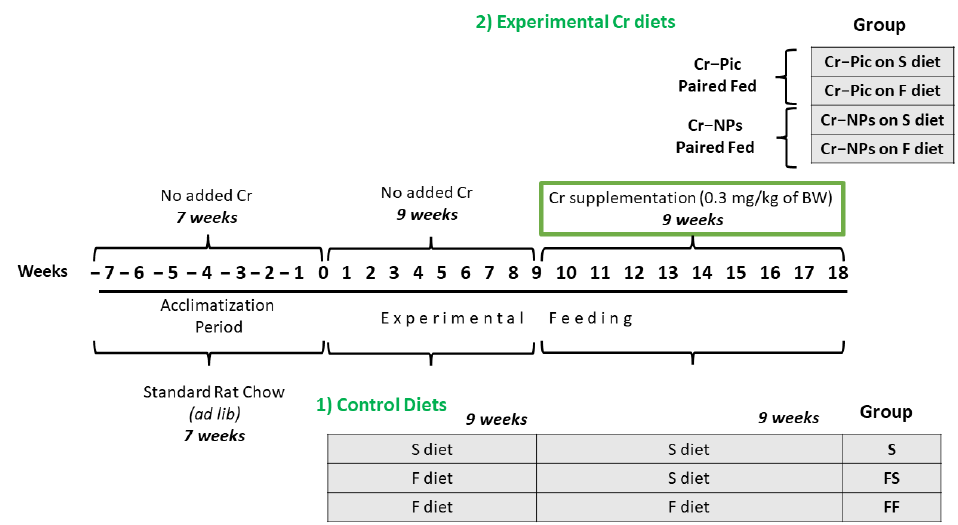
Figure 1. Animal feeding groups and experimental timeline. 0.3 mg Cr/kg of body weight as chro- mium picolinate (Cr-Pic) and chromium nanoparticles (Cr-NPs) were added to the diet as an emul-